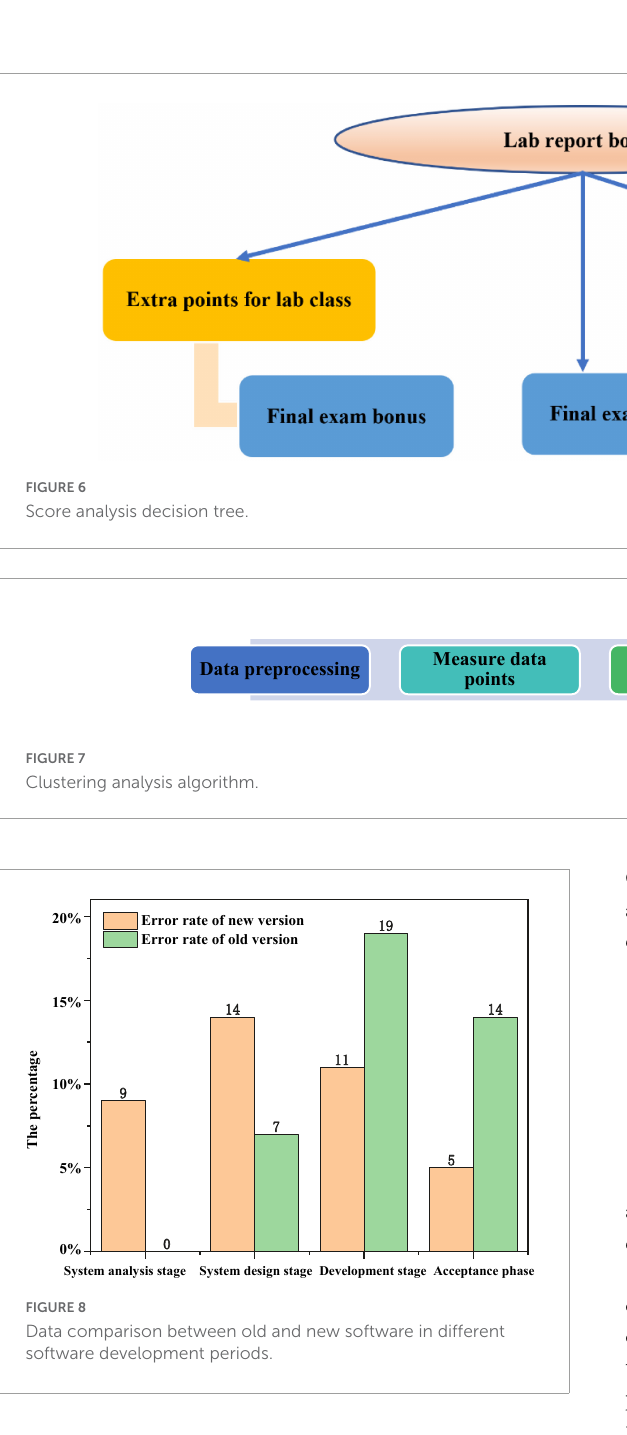
FIGURE8 Data comparison between old and new software in different software development periods.